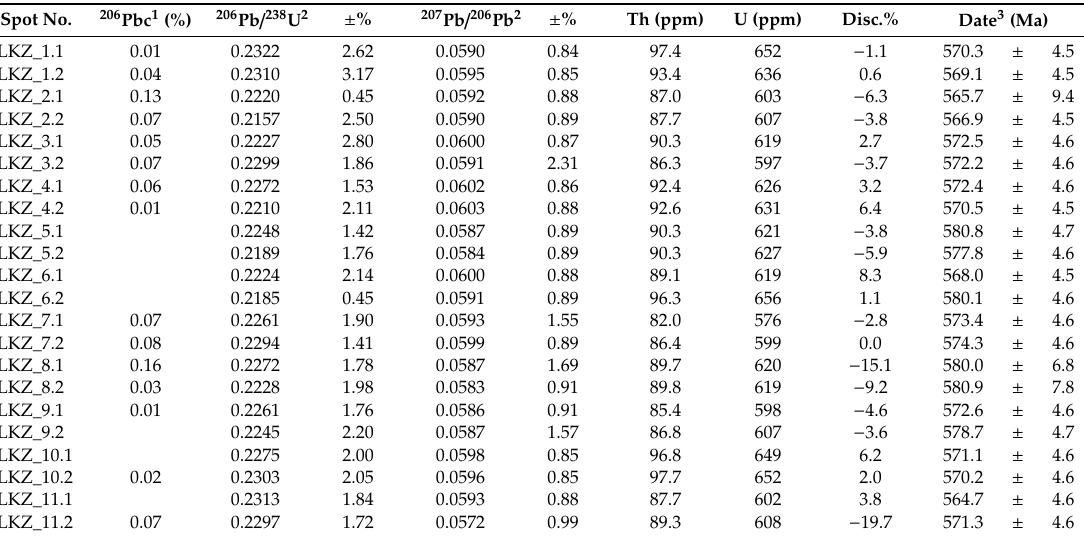
Table 2. SHRIMP U–Th–Pb results for the LKZ-1 zircon. Spot No.